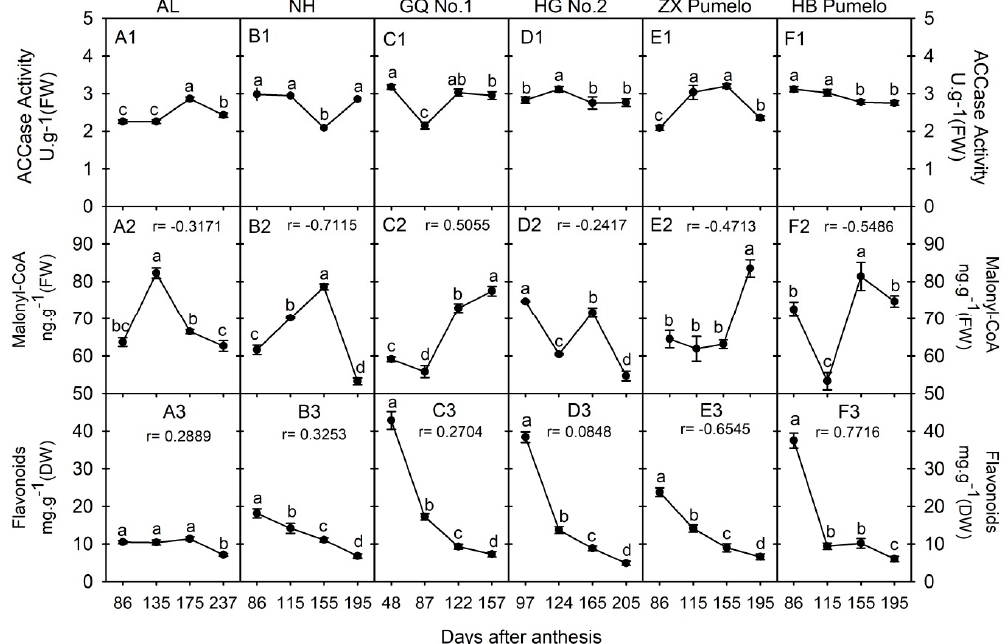
Figure 5. Changes of acetyl-CoA carboxylase (ACCase) activity ( A1~F1 ), malonyl-CoA ( A2~F2 ) and flavonoids (A3~F3) concentration in the fruit juice sacs during fruit development and ripening of six citrus cultivars. AL refers to ‘Anliu’ orange. NH refers to ‘Newhall’ navel orange. GQ No. 1 refers to ‘Guoqing No. 1 ′ Satsuma mandarin. HG No. 2 refers to ‘Huagan No. 2 ′ ponkan. ZX pumelo refers to ‘Zaoxiang’ pumelo. HB pumelo refers to ‘HB’ pumelo. Different lowercase letters on the bar in each graph indicate significant differences at p < 0.05 among samples at different stages by Duncan’s multiple range test. r refers to the correlation coefficient between the malonyl-CoA or flavonoids concentration and the ACCase activity in each cultivar.